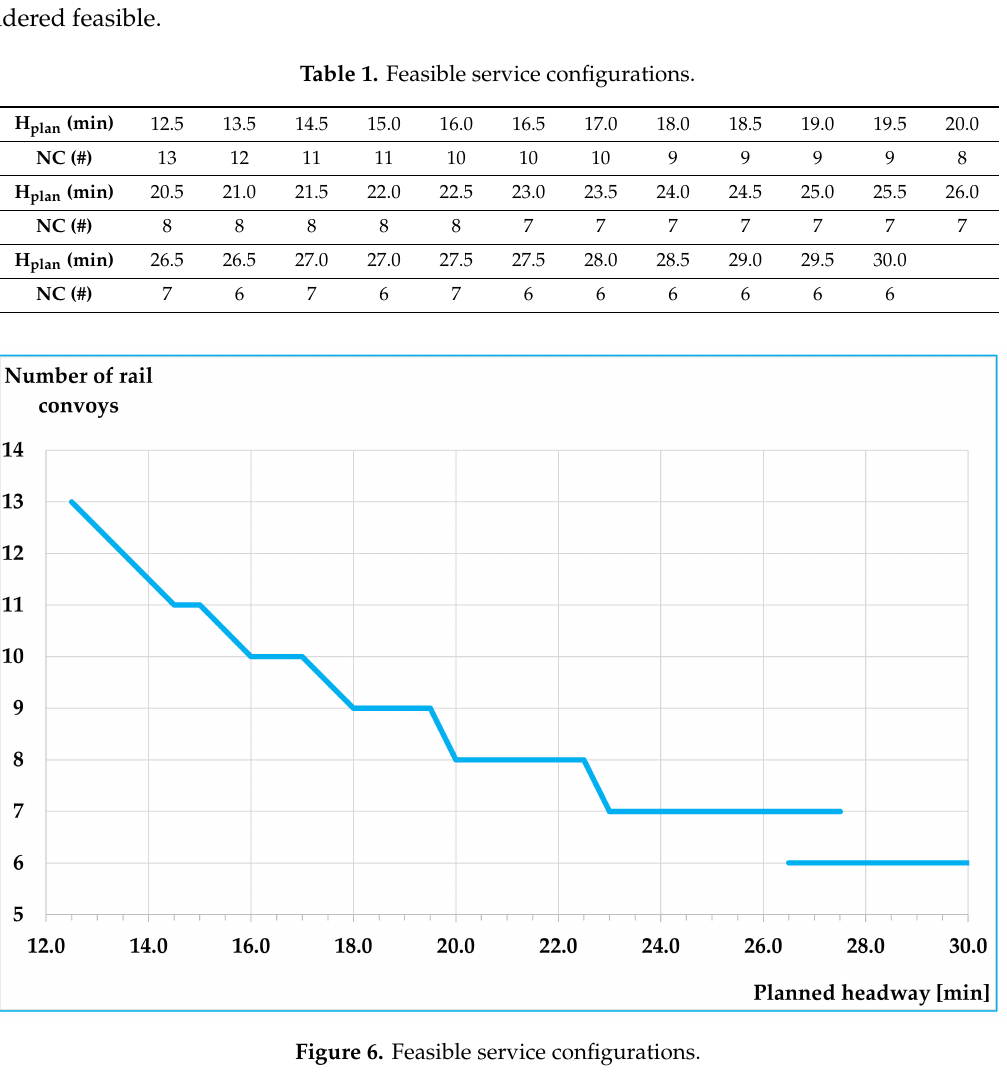
Figure 6. Feasible service